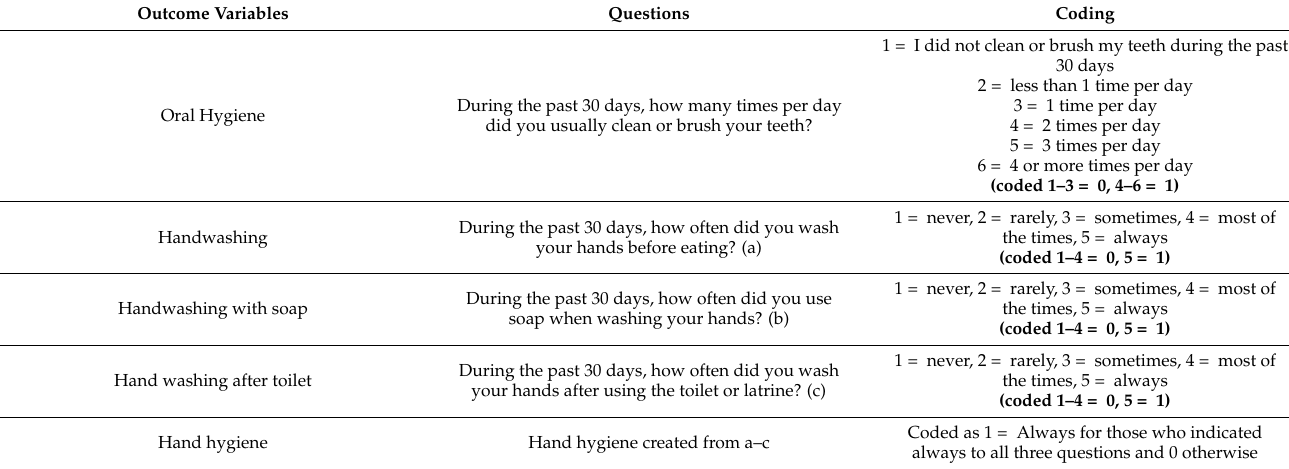
Table 1. Description of the Study